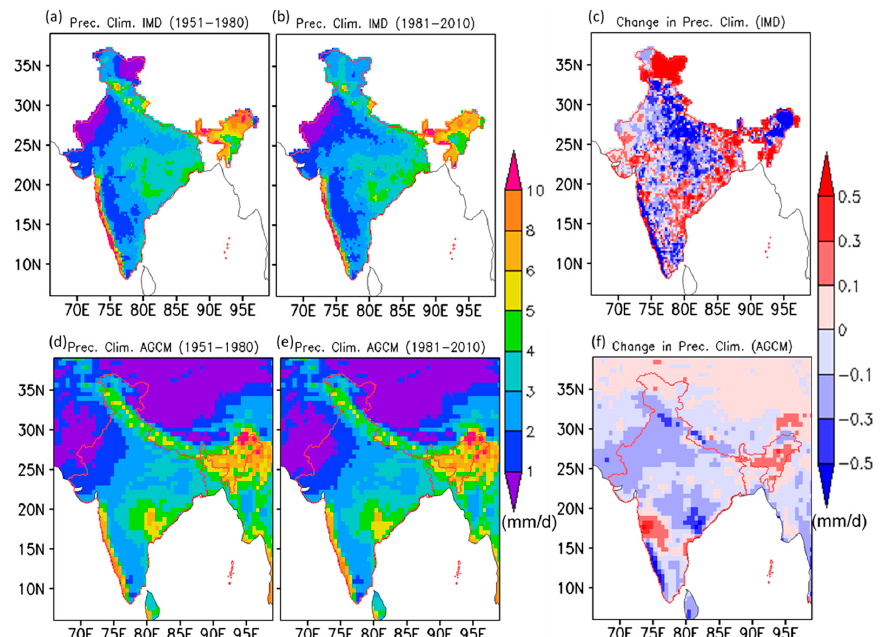
Figure 6. Precipitation climatology in two climate periods from ( a , b ) AGCM ensemble and ( d , e ) IMD observation. Change in precipitation climatology from ( c ) IMD and ( f ) AGCM.